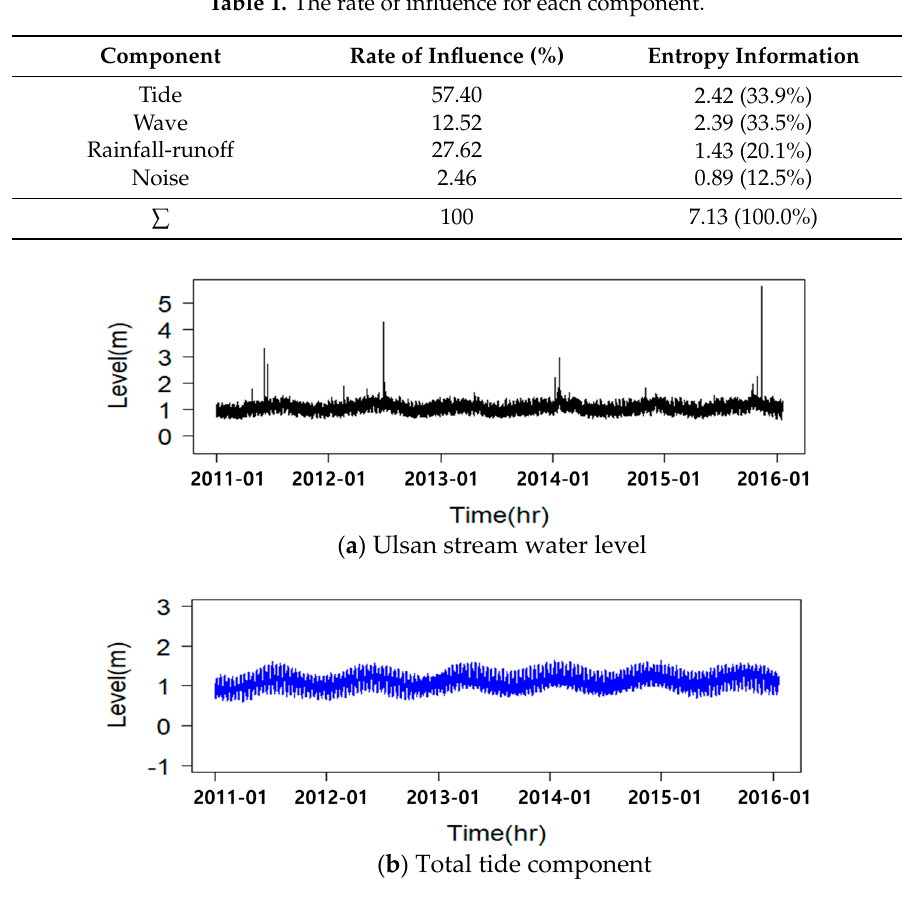
Figure 8. Noise and rainfall-runoff components. High pass filter was applied because the noise component has a high frequency characteristic as shown in Figure 2. Finally, Rainfall-runoff component could be separated by subtracting the value from ( a ) Stream water level–tide level to ( b )